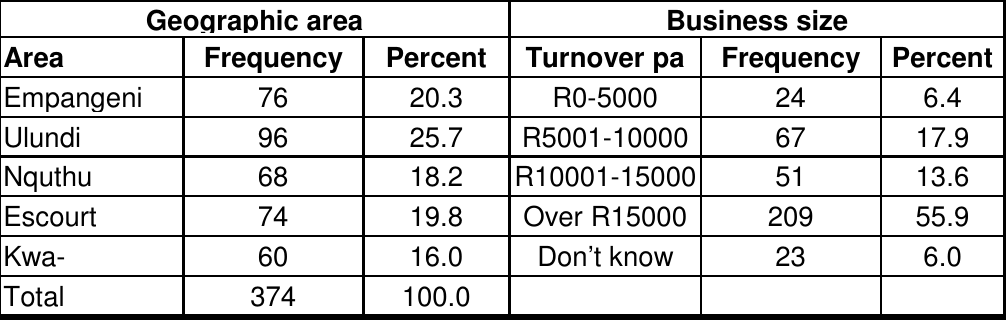
Table 1: Profile of usable sample as per quota characteristics Geographic area